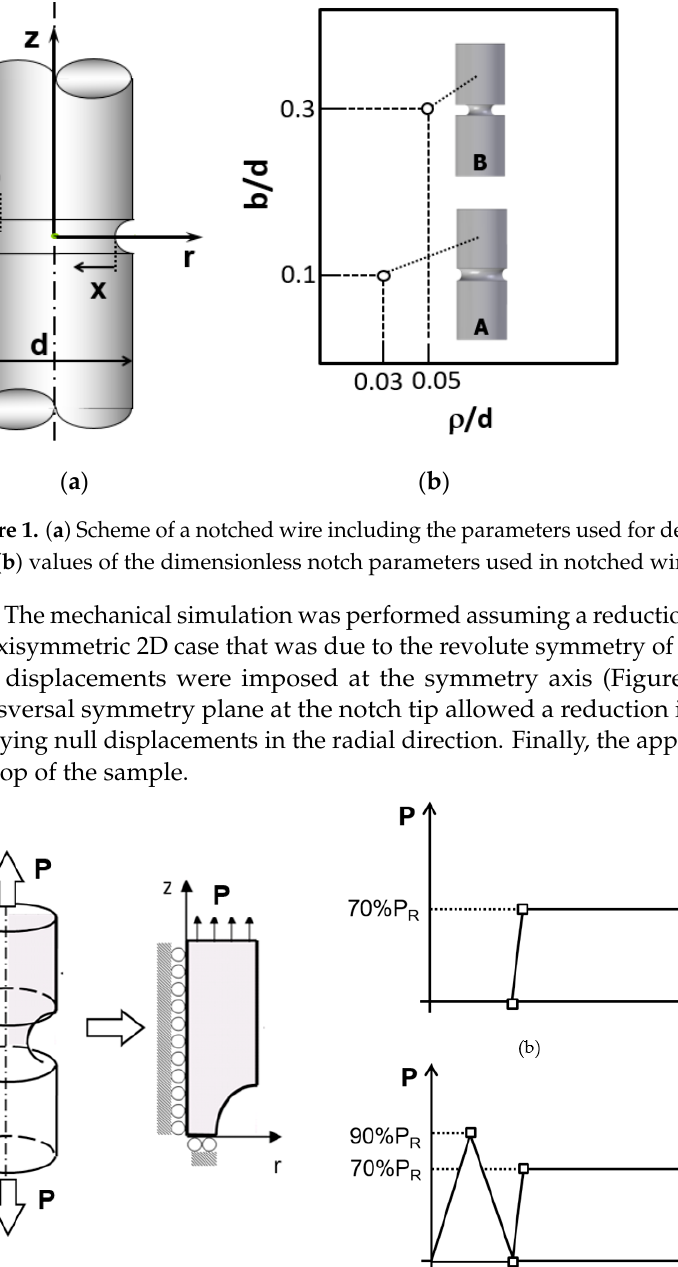
Figure 2. ( a ) Scheme of the reduction in the 3D geometry to an axisymmetric case including the imposed boundary conditions and load history: ( b ) without preload and ( c ) with preload.